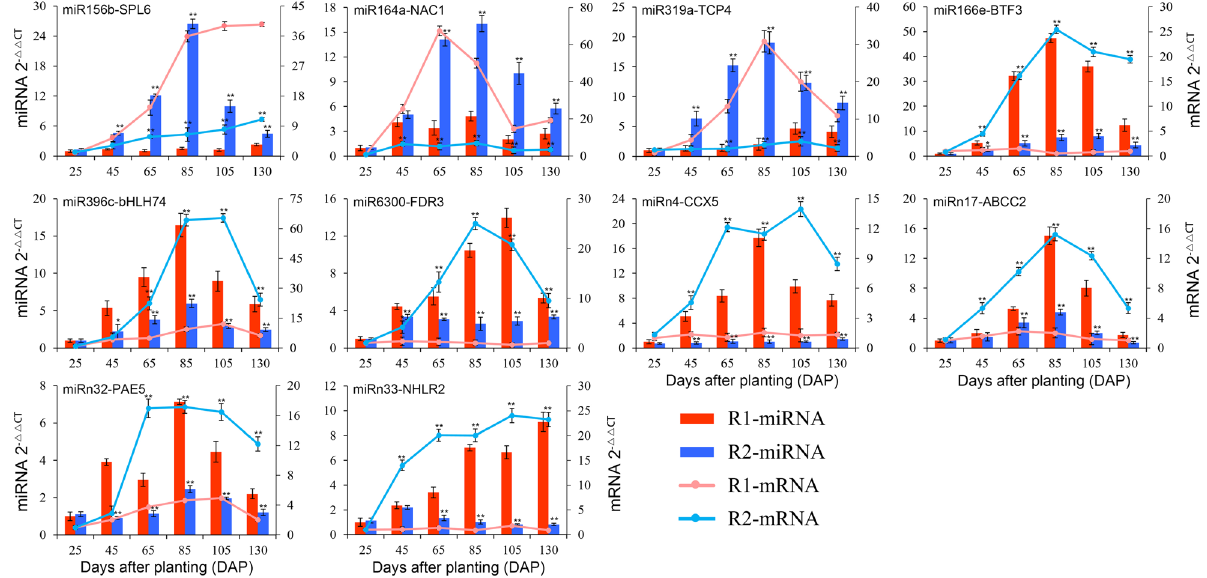
Figure 7. Expression patterns of 10 miRNA-target modules from R1 and R2